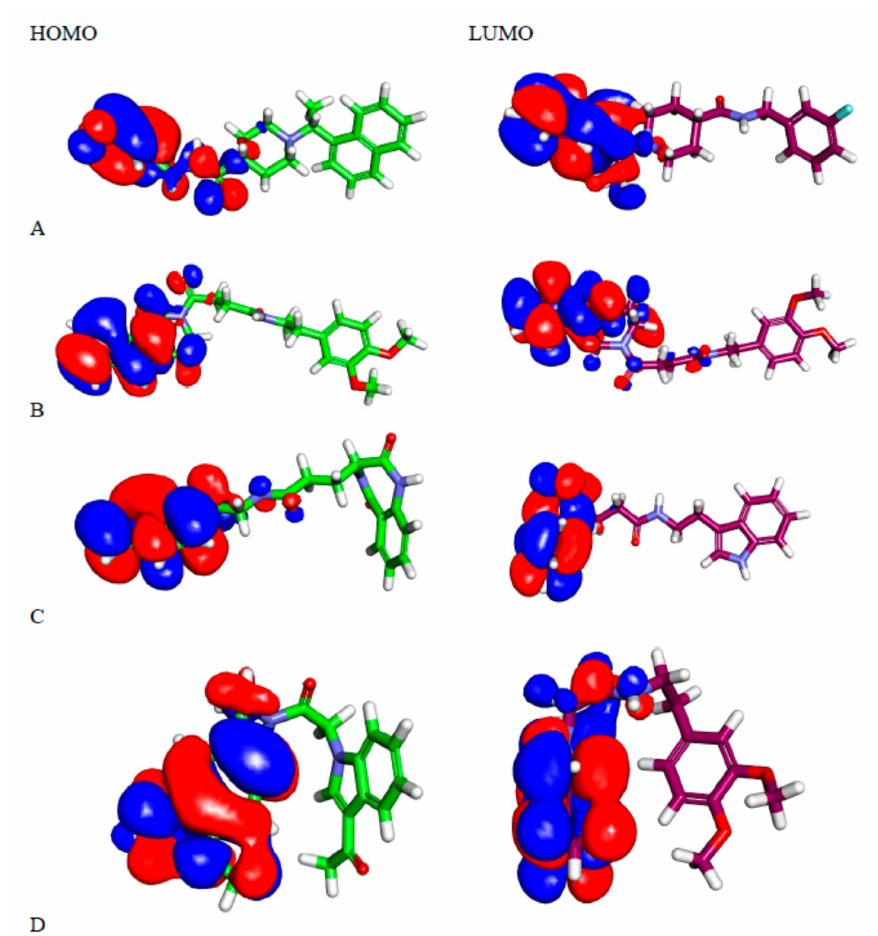
Figure 12. Spatial distribution of molecular orbitals for ( A ) S88 , ( B ) 28 , and ( C ) 34 , and ( D ) 47 . Compound 28 showed five red patches and two blue patches, which can form hy- drogen bond acceptors and hydrogen bond donors, respectively. The aromatic moieties showed yellow patches, which can form hydrophobic interactions with hydrophobic amino acid residues (Figures 12 and